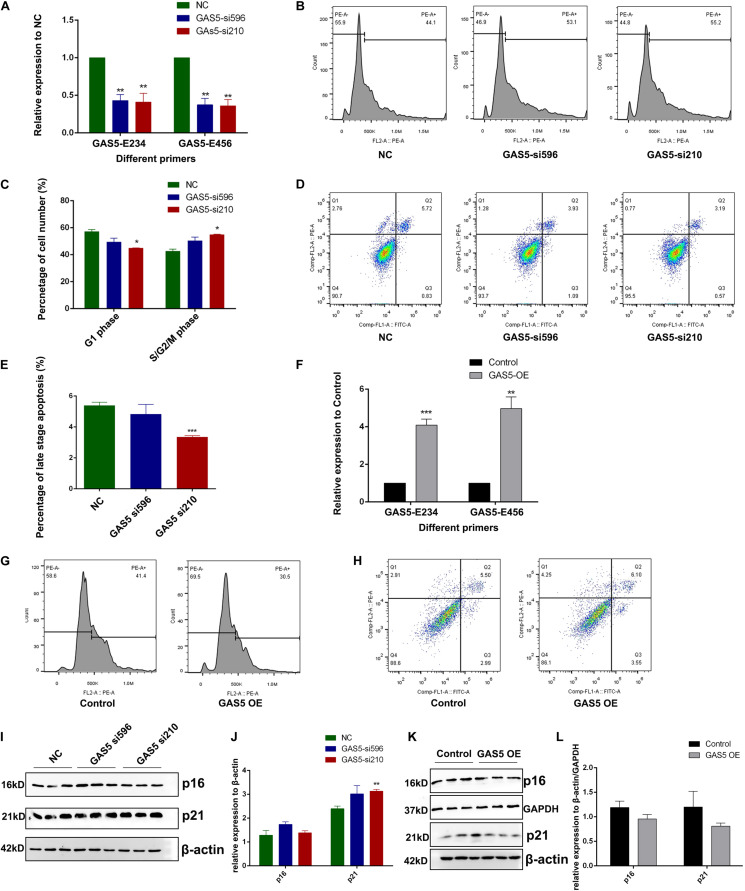
GAS5 inhibits cell growth and promotes apoptosis level in HT22 cells. (A) RT-qPCR was performed to quantify the relative expression of GAS5 using two different primers (GAS5-E234 and GAS5-E456) that can amplify different GAS5 isoforms in GAS5-knockdown (KD) HT22 cells. Two different siRNAs (GAS5-si596 and GAS5-si210) were used to KD GAS5. (B) Cell cycle analysis of GAS5 KD HT22 cell. NC, GAS5-si596, GAS5-si210 represents HT22 cells transfected with negative control siRNA, GAS5 siRNA 596, and GAS5 siRNA 210, respectively. (C) Percentage of cell number at G1 phase and S/G2/M phase during cell cycle was quantified. Columns in different colors represent control and GAS5 KD groups. (D) Cell apoptosis analysis of GAS5 KD in HT22 cells. Cells stained with negative or positive annexin V–fluorescein isothiocyanate and propidium iodide signal were separated into four parts. Top right part represents late-stage apoptosis cell. (E) Percentage of late-stage apoptosis cell number was quantified. Columns in different colors represent control and KD groups. (F) pcDNA3.1(+) vector contains GAS5 cDNA was introduced to overexpress GAS5 in HT22 cells. RT-qPCR was performed to quantify the relative expression of GAS5. (G) Cell cycle analysis of GAS5 overexpression (OE) in HT22 cells. (H) Cell apoptosis analysis of GAS5 OE HT22 cells. (I) Immunoblot result of p16 and p21 in GAS5-KD HT22 cells. β-actin was used as a loading control. Intensity quantification was showed in (J). (K) Immunoblot result of p16 and p21 in GAS5 OE HT22 cells. β-actin and GAPDH were used as loading control. Intensity quantification was showed in (L). Three biological repeats were performed in each experiment, except for (G,H) (N = 1). *P < 0.05; **P < 0.01; ***P < 0.001.